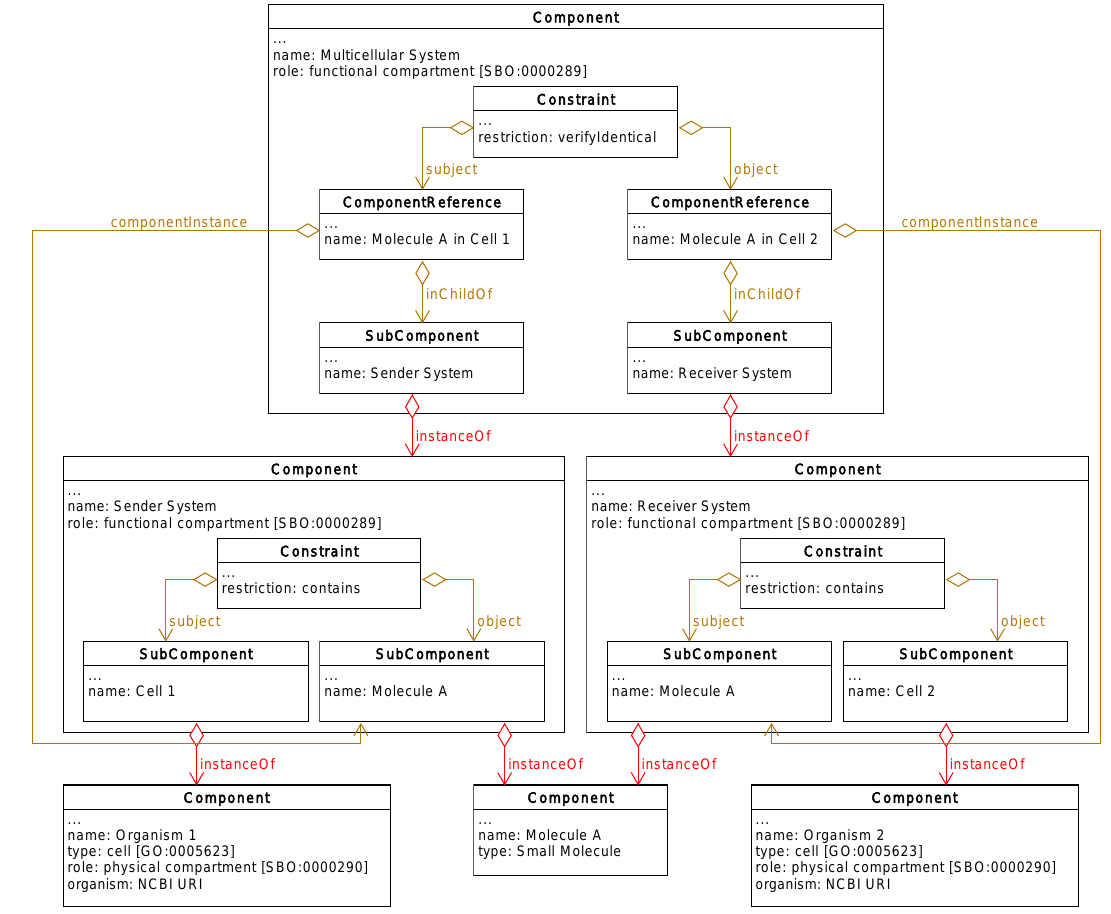
Figure 23: Captured here is a design involving two cells which both interact with the small molecule “Molecule A”. Designs for the sender and receiver systems are captured using constraint to show that each of these cells interacts with the Molecule A contained within it. The overall multicellular system is represented by a Component with a role of “functional compartment”, which is an SBO term. The two systems are included in this multicellular design as SubComponent s, and the fact that Molecule A is shared between systems is indicated with a constraint.